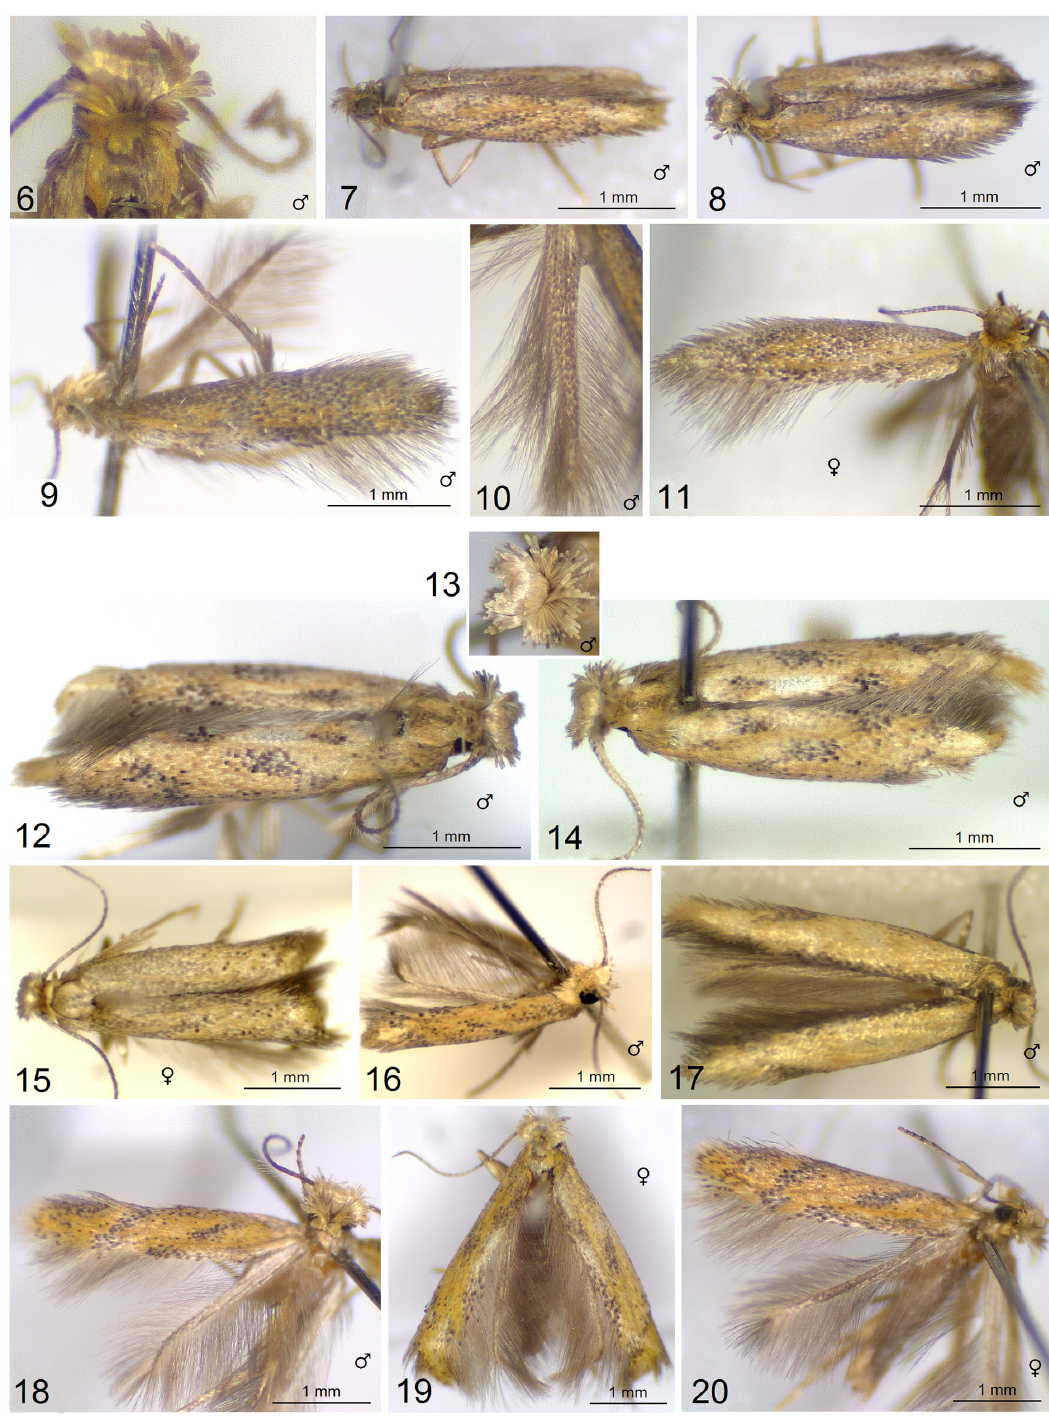
Figs 6–20. Tischeriidae collected in Las Cuevas, Belize. 6 . Astrotischeria papilloma sp. nov., head, paratype (NHMUK 010289202). 7 . Same, holotype (010289201). 8 . Same, paratype (010289202). 9 . A. scutifera sp. nov., holotype (010289214). 10 . Same, paratype, hindwing (010289218). 11 . Same, paratype (010289221). 12 . A. basilobata sp. nov., holotype (010289226). 13 . Same, frontal tuft. 14 . Same, dorso-lateral view. 15 . A. selvica , paratype (010289241). 16 . A. casila , holotype (010289244). 17 . A. furcata , holotype (010289261). 18 . Paratischeria robinsoni sp. nov., holotype (010289262). 19 . Same, paratype (010289269). 20 . Same, paratype